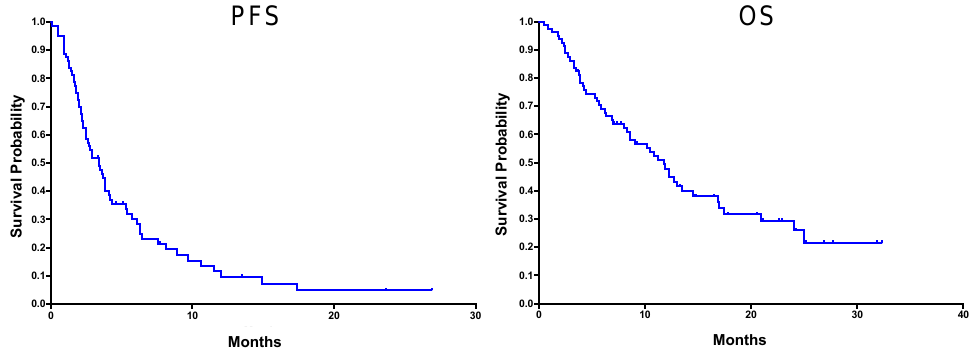
Figure 1. Kaplan–Meier (KM) curves showing PFS (left) and OS (right) for all 80 patients—46 patients with STS and 34 with BS. Median PFS was 3.4 months and median OS was 11.8 months.